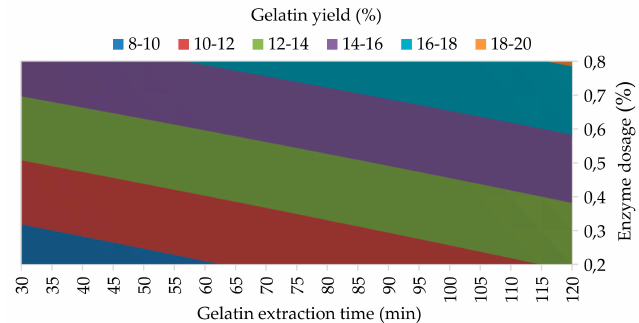
Figure 1. The influence of enzyme dosage and gelatin extraction time (at 48 h of enzyme processing time) on the yield of the 1st gelatin